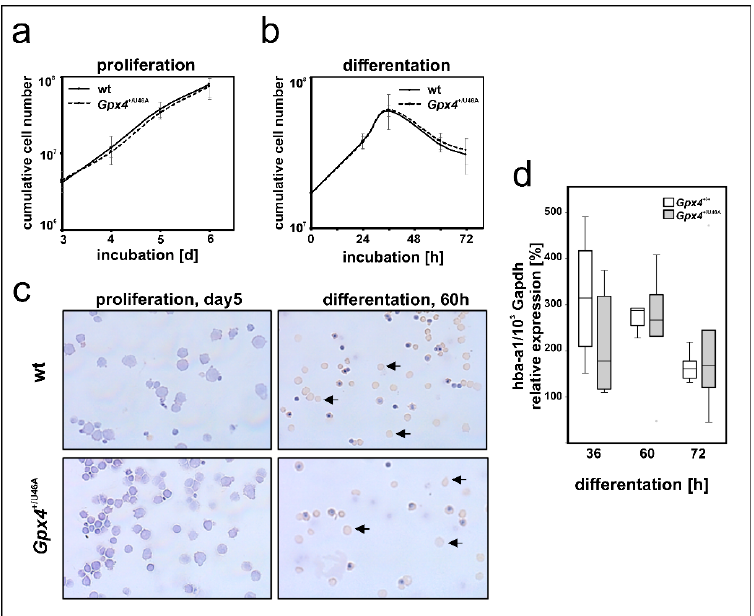
Figure 8. Heterozygous expression of a catalytically inactive Gpx4 in mice does not impact ex vivo erythropoiesis of embryonic liver derived erythroblasts. Fetal livers of day 12.5 mouse embryos (wild type and Gpx4 +/U46A ) were prepared, homogenized and primary erythroblasts were expanded for 5 days in STEMPRO TM -34 SFM medium containing 50 ng/mL recombinant murine stem cell factor, 1 U/mL human erythropoietin-alpha, and 1 µ M dexamethasone. Terminal erythroid differentiation was induced in continuously proliferating erythroblasts by exposure to 5 U/mL erythropoietin-alpha and 0.5 mg/mL iron loaded human transferrin as described in Material and Methods. ( a ) Cumulative cell number of proliferating erythroblasts derived from Gpx4 +/U46A and the corresponding wild-type controls (n = 3). ( b ) Cumulative cell number after induction of terminal erythroid differentiation (n = 3). ( c ) Morphological and histochemical analysis of proliferating and differentiated wild type (upper panels) and Gpx4 +/U46A (lower panels) mouse erythroblast. Proliferating erythroblasts (5 days) and erythroblasts that have been differentiated for 60 h in the presence of erythropoietin were HE stained and subsequently counterstained stained with neutralized benzidine to detect hemoglobin expression (arrows). ( d ) Hba-a1 mRNA expression during terminal differentiation in wildtype ( Gpx4 +/+ ) and Gpx4 deficient ( Gpx4 +/U46A ) cells. Total RNA was extracted at different time points of the culturing period. The steady-state concentrations of Hba-a1 mRNA was related to Gapdh mRNA as described in the Material and Methods section. n = 5. Significances were calculated using the Mann-Whitney U test and p -values < 0.05 were considered statistically